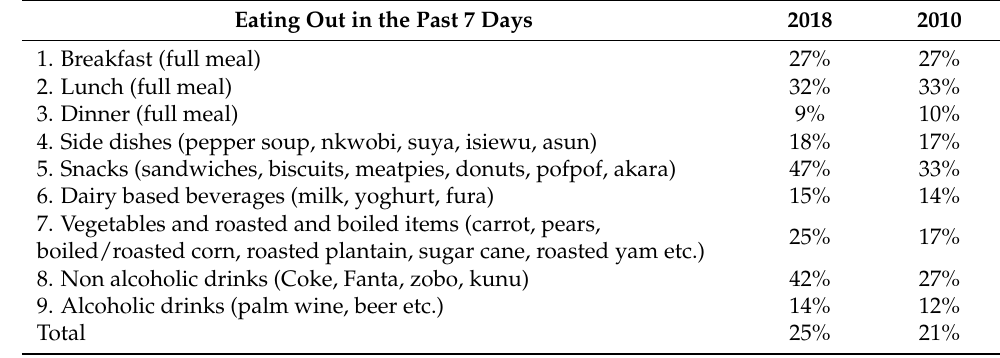
Table 8. Meals eaten out of home in the 7 days prior to the survey in 2018 versus 2010 [11,12]. Eating out in the past 7 days